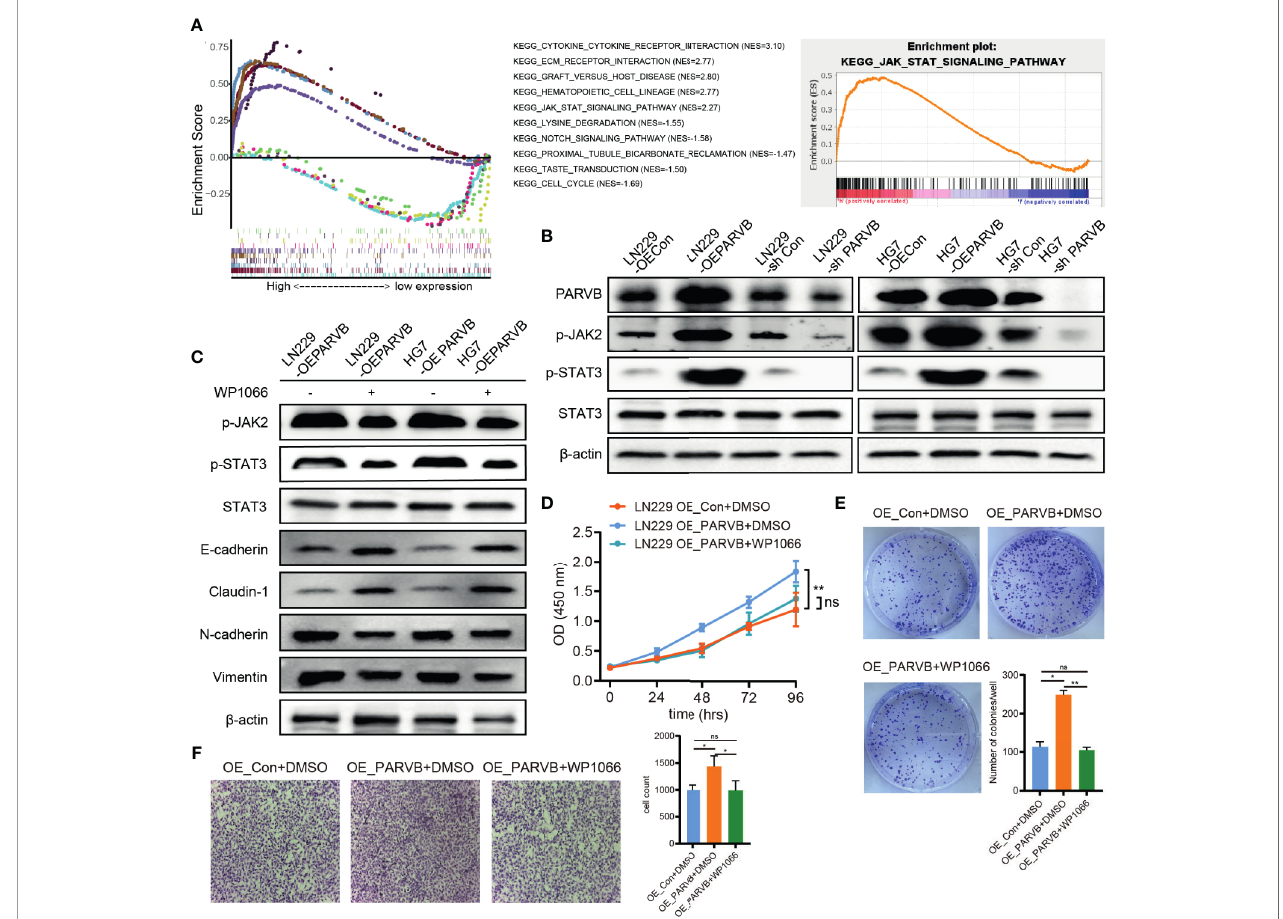
FIGURE 9 | PARVB promotes EMT by activating the JAK2/STAT3 pathway. (A) GSEA of the top fi ve negative and positive function gene sets associated with PARVB expression. The high expression PARVB group was positively correlated with the JAK-STAT pathway. (B) Western blot analysis shows that p-JAK2 and p- STAT3 expression was upregulated by PARVB overexpression and was downregulated by PARVB knockdown in LN229 and HG7 cells. (C) Western blot analysis of the indicated proteins in LN229 and HG7 GBM cells overexpressing PARVB with WP1066 (200 nM) treatment. Activating JAK2/STAT3 pathway signi fi cantly promoted EMT in LN229 and HG7 cells. Conversely, inhibitor of JAK2/STAT3 signaling partially rescued EMT in LN229 cells. (D) CCK-8 assay analysis of the effect of WP1066 on LN229 cells after overexpression of PARVB at the indicated times. Silencing JAK2/STAT3 signaling via WP1066 partly inhibited the increased proliferation in PARVB-overexpressing LN229 cells, whereas activating JAK/STAT signaling promotes proliferation of PARVB-knockdown LN229 cells. (E) Colony formation assay of the effect of WP1066 on the growth of LN229 GBM cells after overexpression of PARVB in a 6-well dish (800 cells per well) for 8 days. Representative images and statistical analysis of three independent assays are shown, quanti fi cation data are expressed as average ± SD. (F) Transwell migration analysis showing the effect of WP1066 on LN229 cells after overexpression of PARVB on LN229 GBM cells. Silencing JAK2/STAT3 signaling via WP1066 partly inhibited the increased migration and invasion in PARVB-overexpressing LN229 cells, whereas activating JAK/STAT signaling partially rescued the inhibited migration and invasion of PARVB-knockdown LN229 cells. Representative images and statistical analysis of three independent assays are shown, quanti fi cation data are expressed as average ± SD. Signi fi cant results are presented as ns (non-signi fi cant), *p < 0.05, and **p <